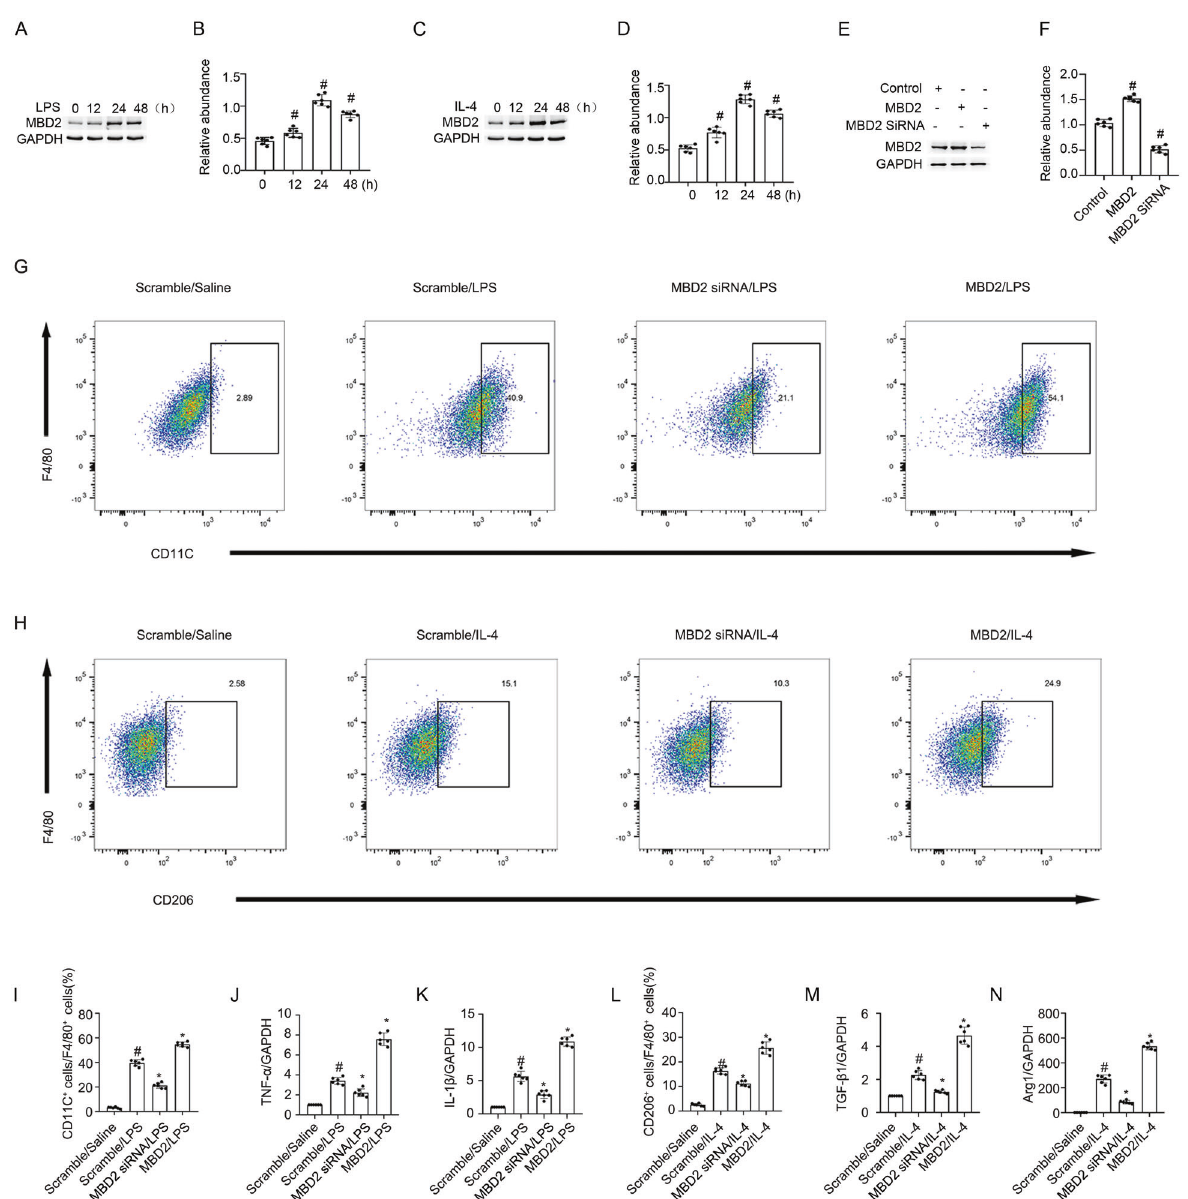
Densitometry analysis of proteins levels, and normalized to internal control of GAPDH. G and I Representative FCM analysis the ration of M1 (CD11C + cells vs. F4/80 cells). H and L Representative FCM analysis the ration of M2 (CD206 + cells vs. F4/80 cells). J The expression levels of TNF- α were detected by real-time qPCR. K The expression levels of IL-1 β were detected by real-time qPCR. M The expression levels of TGF- β 1 were detected by real-time qPCR. N The expression levels of Arg1 were detected by real-time qPCR. Data are expressed as means ± sd ( n =